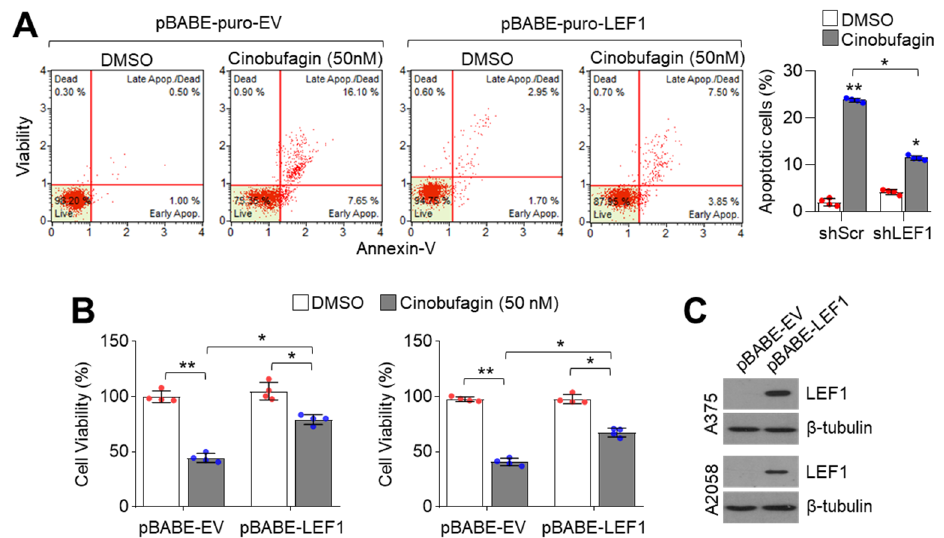
Figure 5. Cinobufagin suppresses melanoma cell growth by suppressing LEF1. ( A ) Cinobufagin induces apoptosis. LEF1 stably expressing A375 melanoma cells were incubated with cinobufagin for 72 h. The apoptotic cell population was measured by Annexin-V staining as described in the Materials and Methods section. ( B ) Cinobufagin attenuates melanoma cell growth dependent on LEF1 expression. LEF1 overexpressing A375 and A2058 melanoma cells were incubated with cinobufagin for 72 h. Cell viability was measured by crystal violet staining. The values represent the mean ± SD ( n = 4); * p < 0.05 and ** p < 0.01. ( C ) LEF1 expression in pBABE-EV or pBABE-LEF1 expressing A375 and A2058 cells. LEF1 protein levels were measured by Western blotting. Red and blue points, mean value of individual sample.